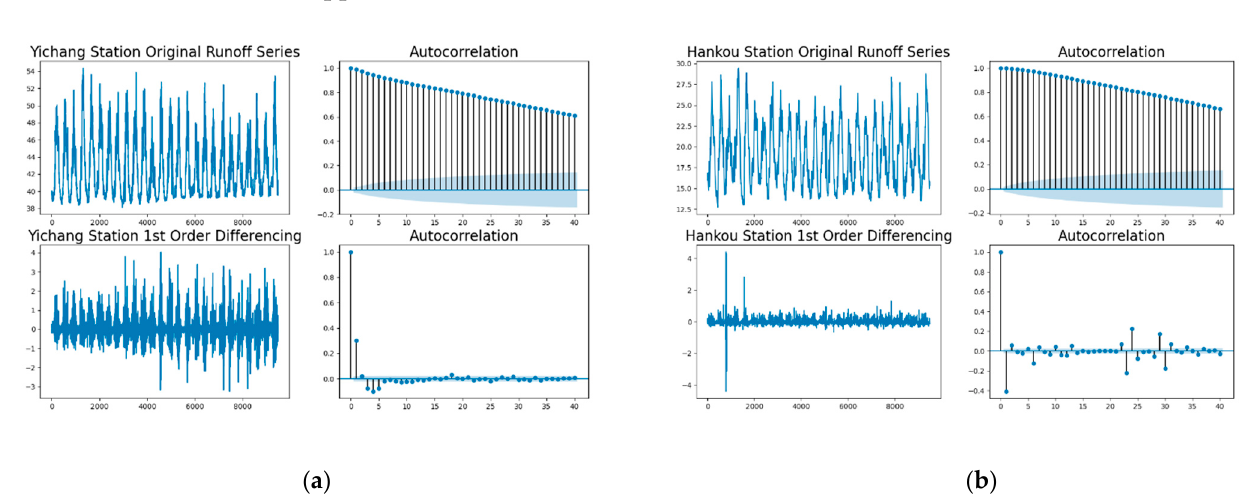
Figure A1. The autocorrelation of two hydrological station runoff series. ( a ) The Yichang Station original runoff series and the first-order difference series with their autocorrelation values. ( b ) The Hankou Station original runoff series and the first-order difference series with their autocorrelation values.